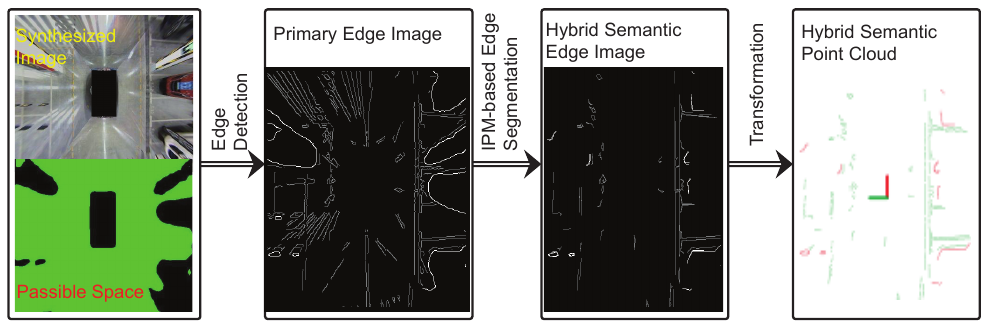
Figure 3. The procedure of hybrid semantic edges